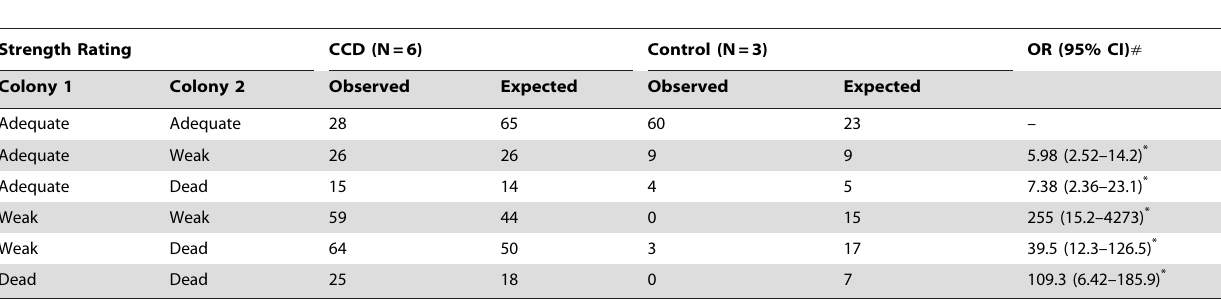
Table 5. Observed and expected frequencies of neighboring colonies with similar or different strength ratings in CCD and control